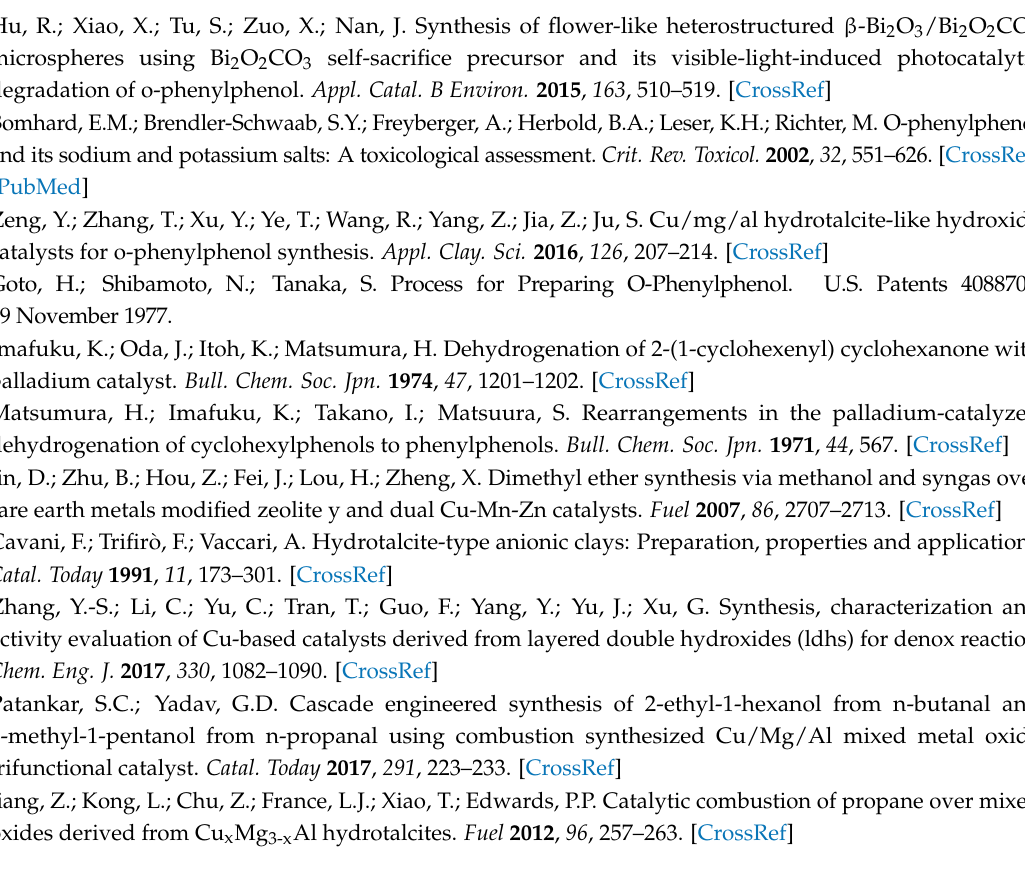
Figure S1: FT-IR image of Cu/Ni/Mg/Al before calcination (a) and calcination (b), Figure S2: TG-DTG of the precursors in N 2 , Figure S3: N 2 adsorption-desorption isotherms of CNMA-(0-4), Figure S4. The pore size distributions for all catalysts, Figure S5: HRTEM and elemental mapping images of catalysts after reduction (a) Cu/Mg/Al/Ni catalysts (b) Cu -K map (c) Ni-K map (d) Mg-K map (e) Al-K map, Table S1: FWHM and the size of Cu 0 particles by XRD, Table S2: The properties of the samples with different amount of Ni, Table S3: Temperatures for Reduction peak and the percentage of α peak for these samples, Table S4: Distribution of the basic type for the samples with different Ni